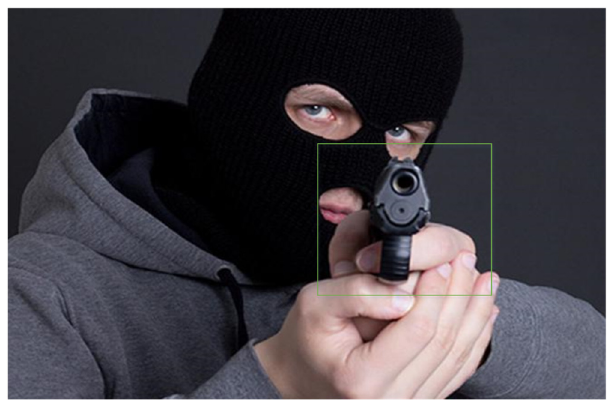
Figure 4. Image scaling and augmentation.